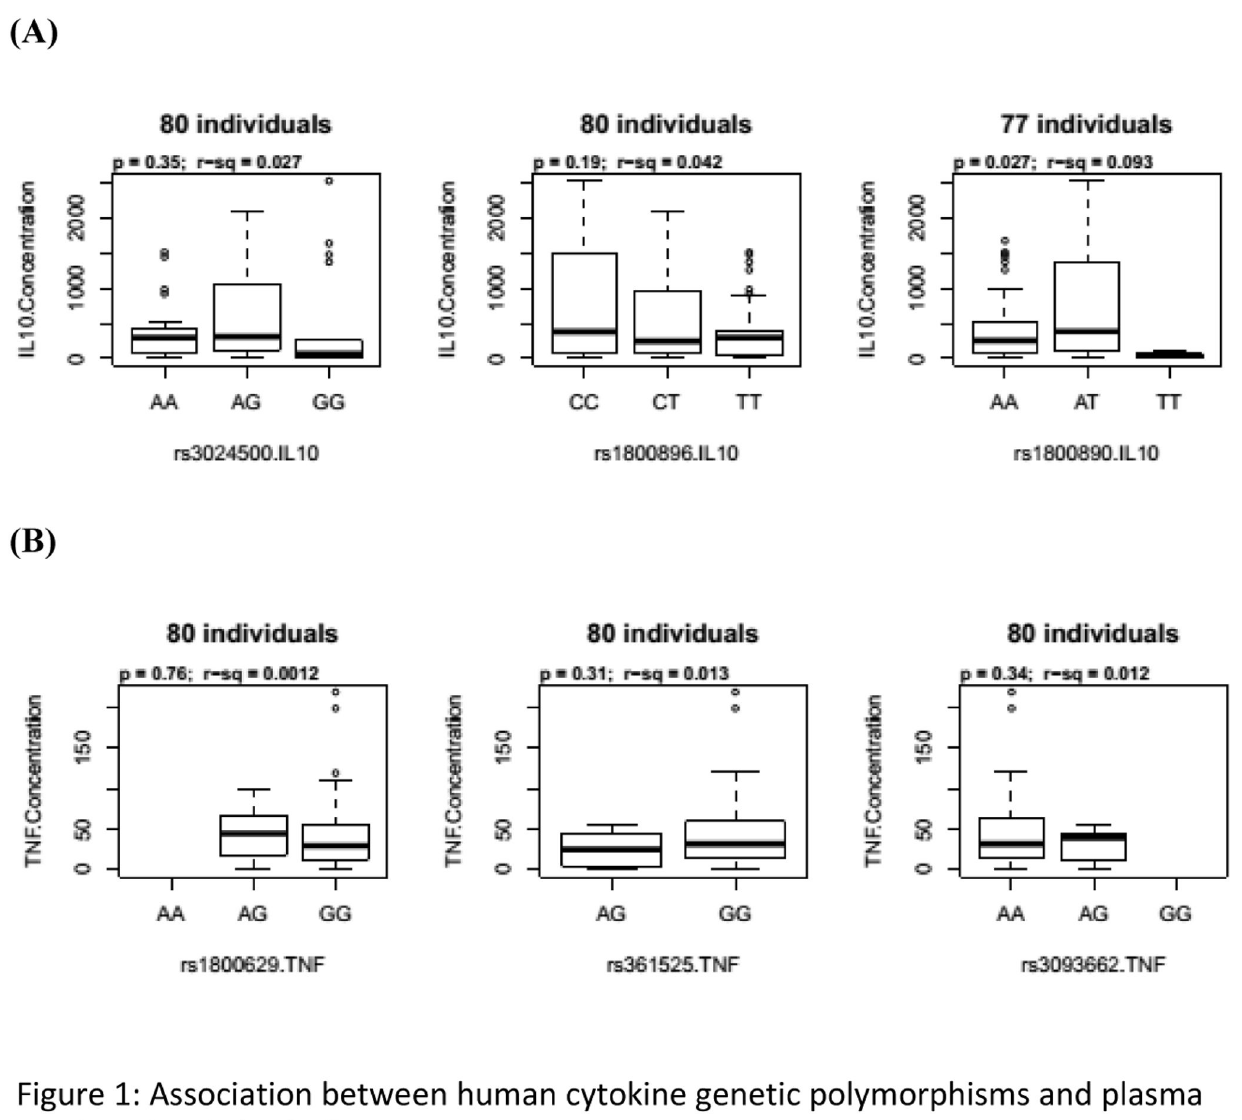
Figure 1. Association between human cytokine genetic polymorphisms and plasma cytokine levels. Plasma cytokine levels measured by ELISA were compared across human IL10 and TNF SNP genotypes of study participants. Of the three polymorphisms assayed for each cytokine, only the AA and TT genotypes of IL10 rs1800890 had lower plasma IL10 levels compared to their AT